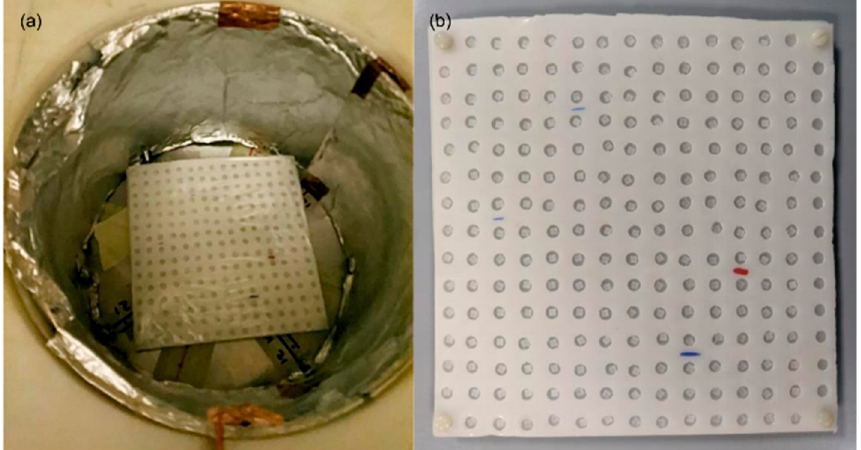
Figure 1. Irradiation set up at HOTNES facility: cylindrical cavity ( a ) with polyethylene support (15 × 15 grid) for thermoluminescent dosimeters ( b ).